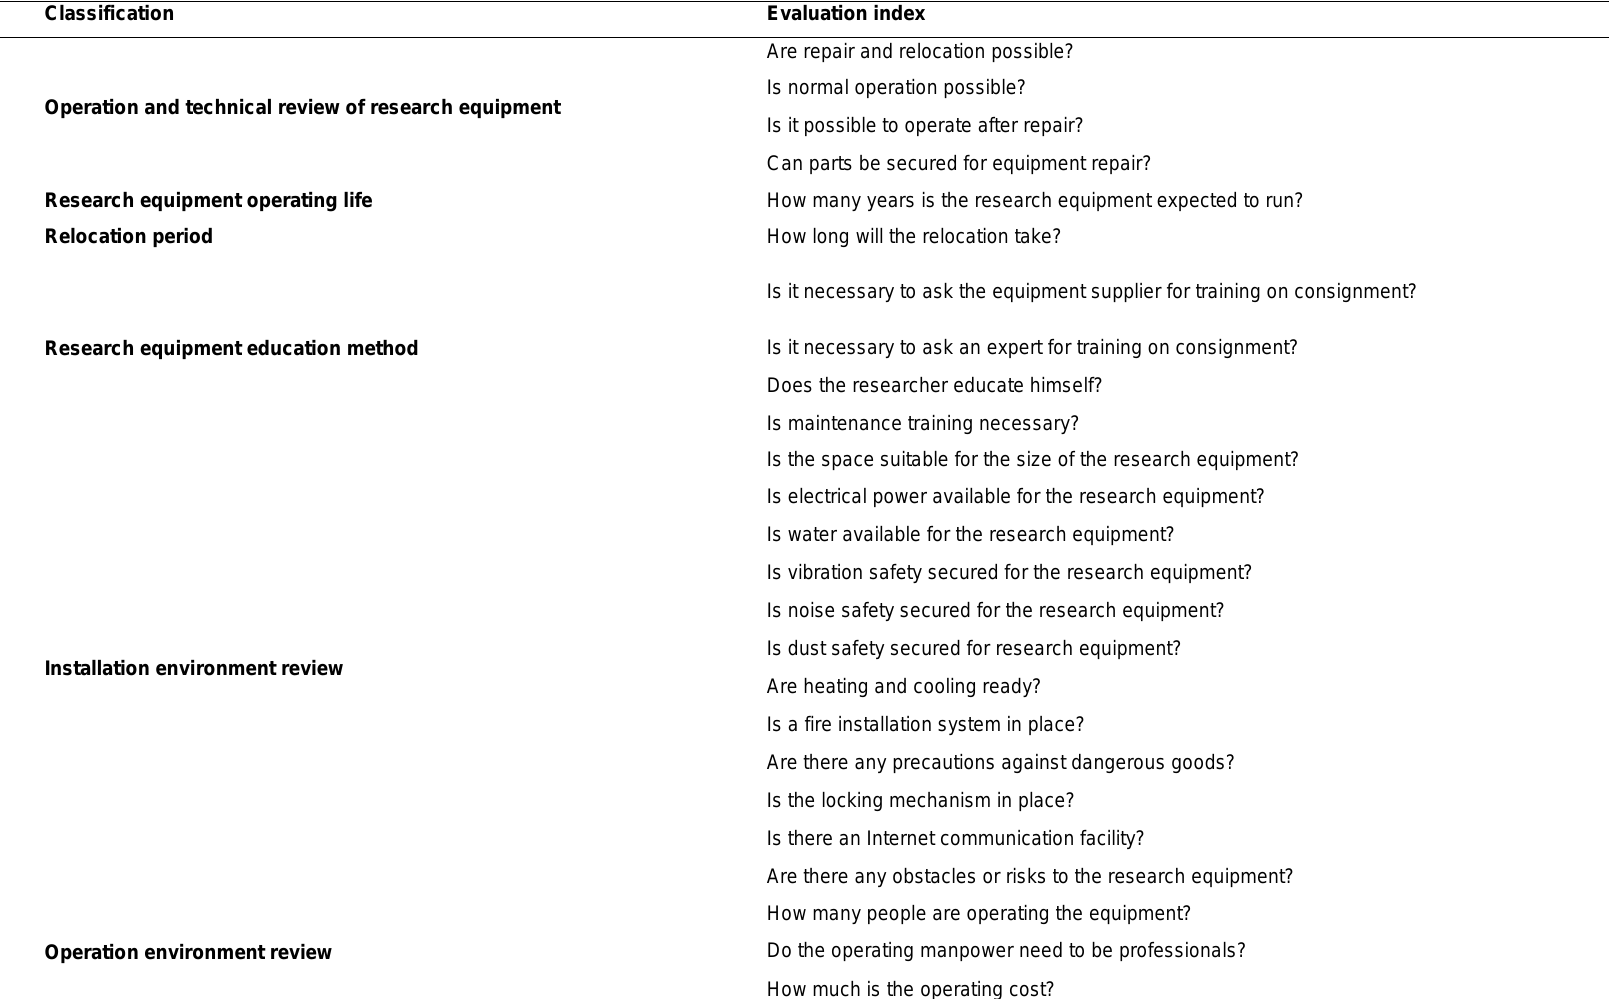
Table 16. Evaluation index for relocation of existing research